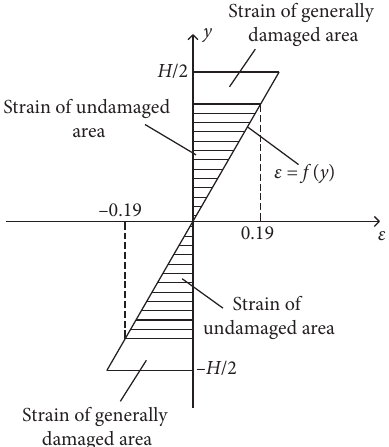
Figure 9: Strain distribution characteristics of generally damaged cross